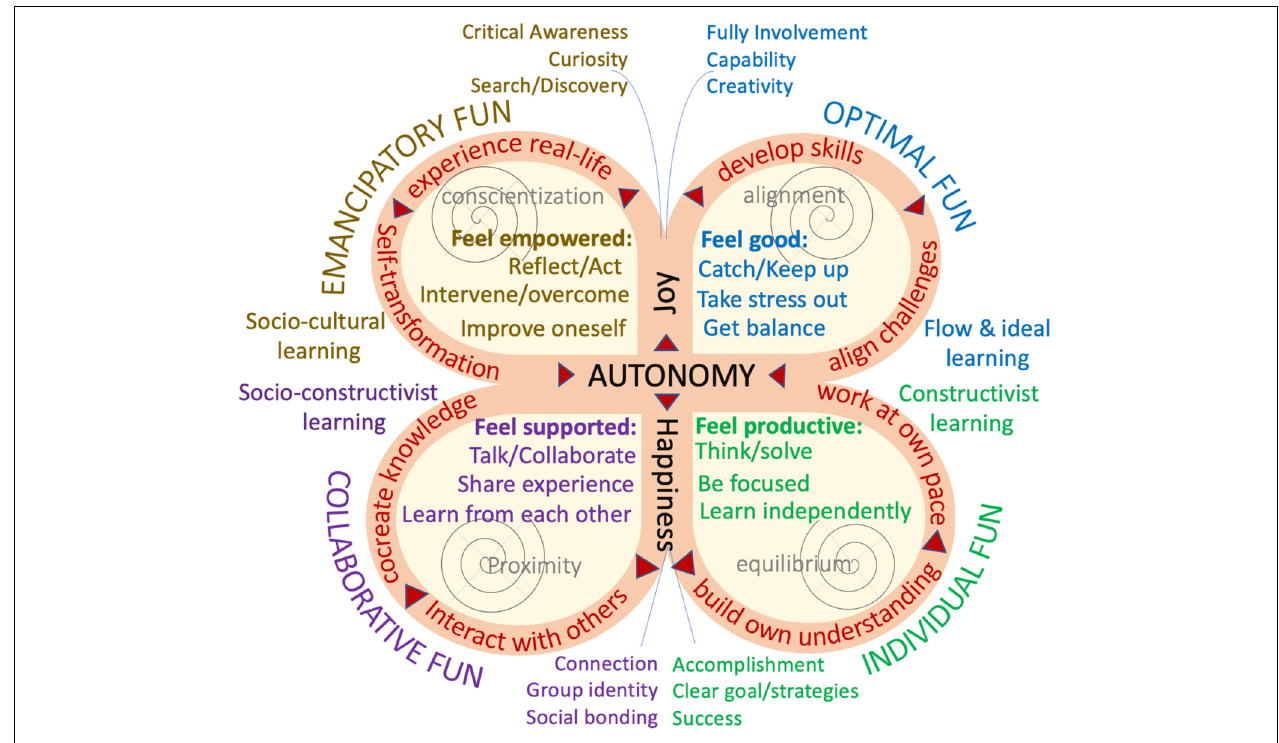
FIGURE 1 | Four levels of Online Learning and Fun (Source: Okada, 2020).